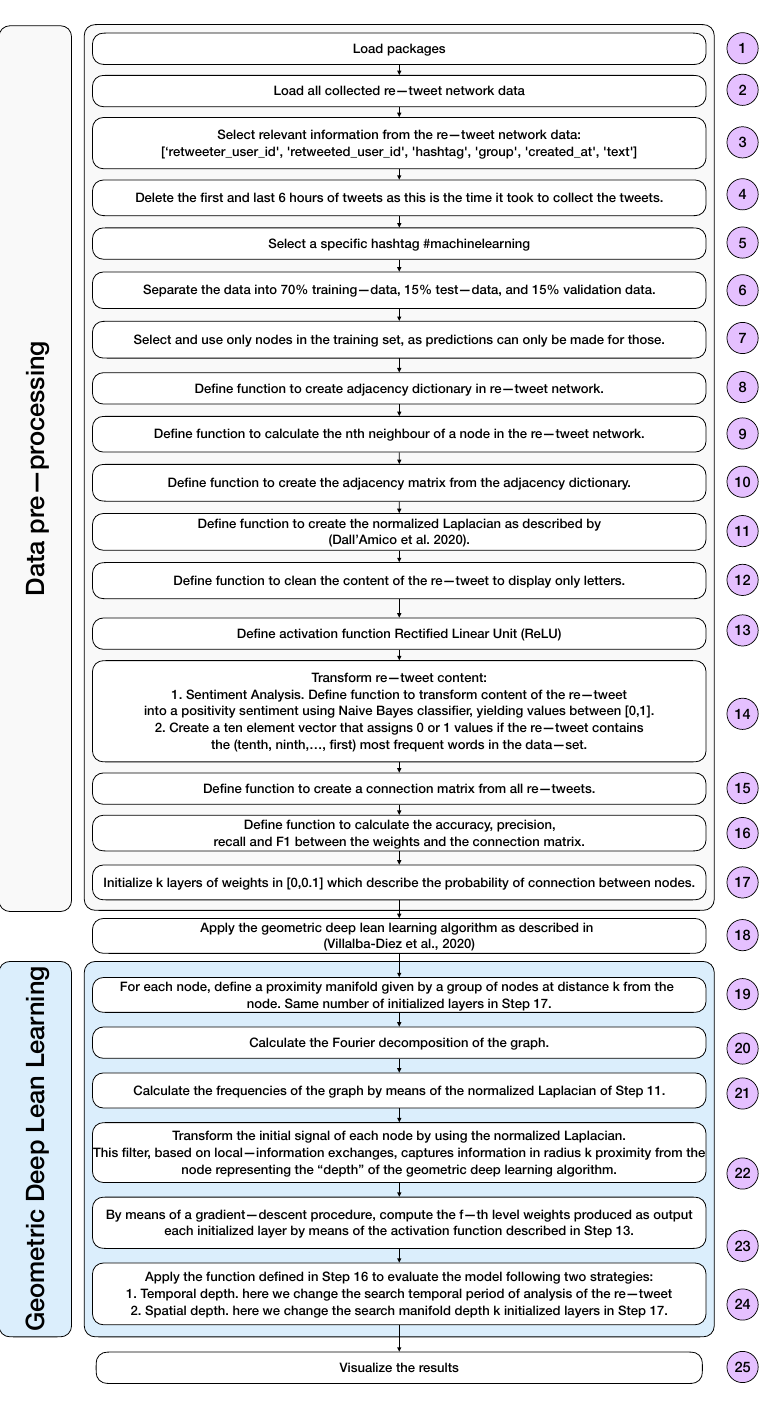
Figure 1. Geometric deep lean learning algorithm flow